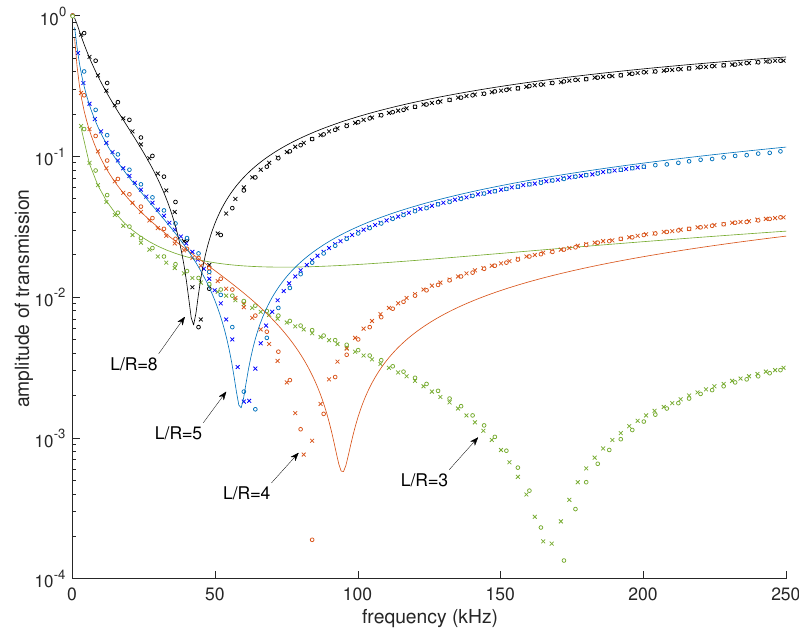
Figure 2. Comparison between the model (Equations (7), solid lines) and the numerical simulations by MST (Multel, crosses) and FEM (COMSOL, circles) for the transmission through arrays of R = 0.1mm air bubbles in water with different lattice constants L